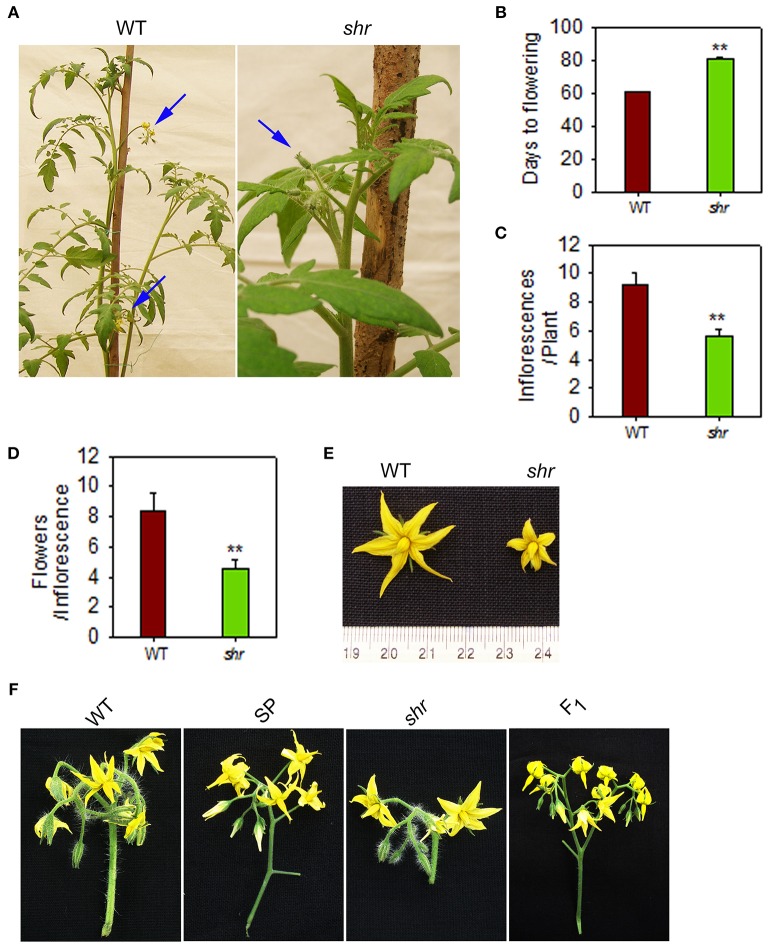
Inflorescence and floral morphology of shr mutant plants. (A) Inflorescence(s) in WT and shr mutant plants. The blue arrow points that WT plant (60-day old) bears two inflorescences whereas shr mutant (80-day old) bear only one inflorescence with unopened flowers. (B) Days from sowing for the onset of the flowering. (C) Number of inflorescences per plant. (D) Number of flowers per inflorescence. (E) Floral morphology of WT and shr mutant. (F) Inflorescence morphology of WT, S. pimpinellifolium (SP), shr and F1. Note: The peduncle of the inflorescence of shr mutant was short and bore less number of flowers compared to WT. The values are the mean ±SD (n = 5). Asterisk indicates statistically significant difference between WT and shr(One-Way ANOVA; **
P < 0.001).